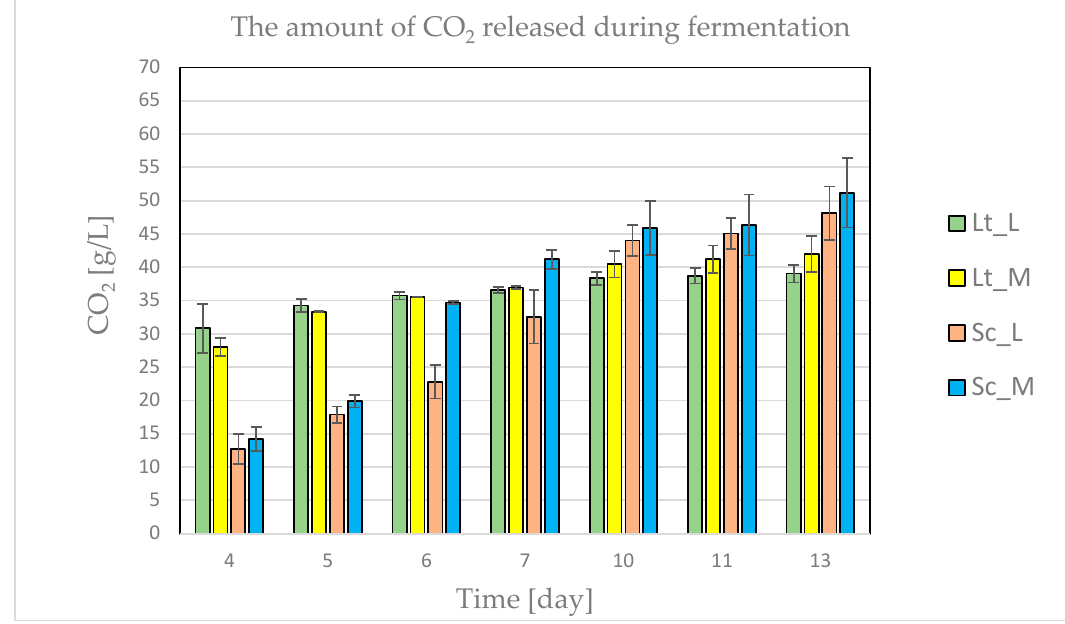
Figure 1. Carbon dioxide evolved during wort (hopped with Marynka (M) or Lubelski (L)) fermentation with L. thermotolerans (Lt) or S. cerevisiae (Sc) yeast.